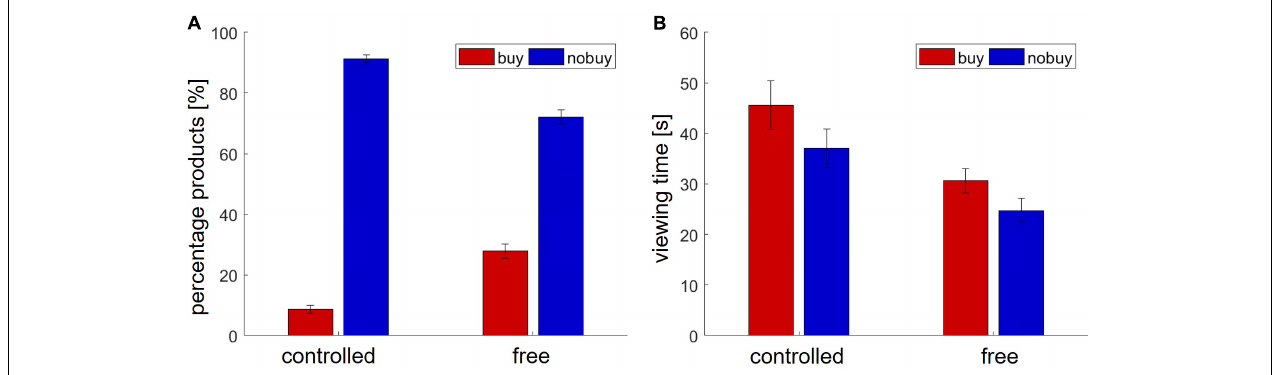
FIGURE 5 | Behavioral results in Study 2. (A) Number of viewed and bought products (B) viewing